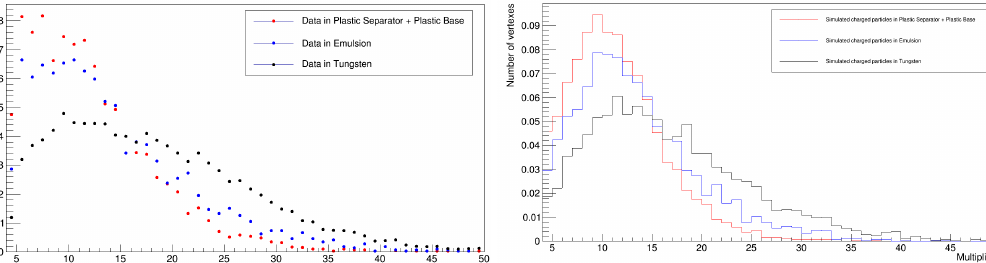
Figure 5. Comparison of normalised multiplicities for the three materials in experimental data ( left ) and in simulations ( right